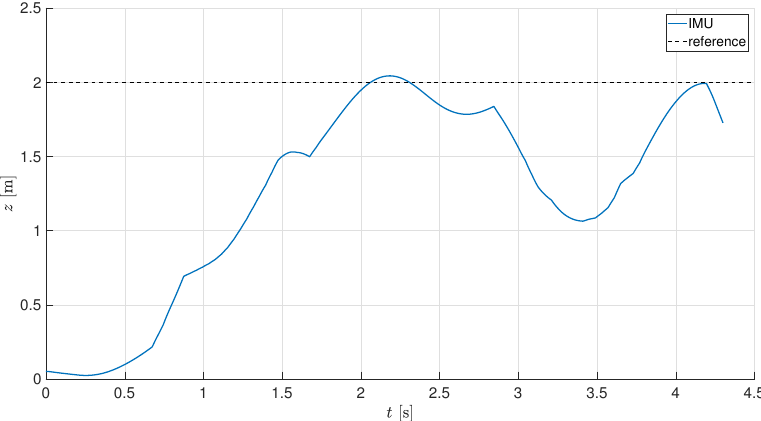
Figure A2. Data from the IMU of the Rolling Spider (reference signal vs. IMU